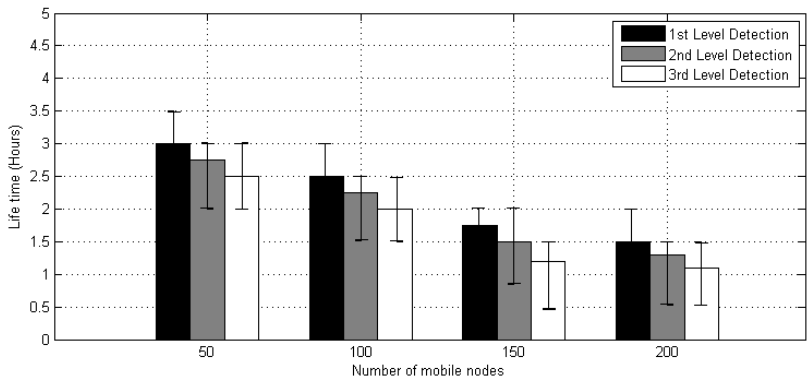
Figure 12. Lifetime of nodes.